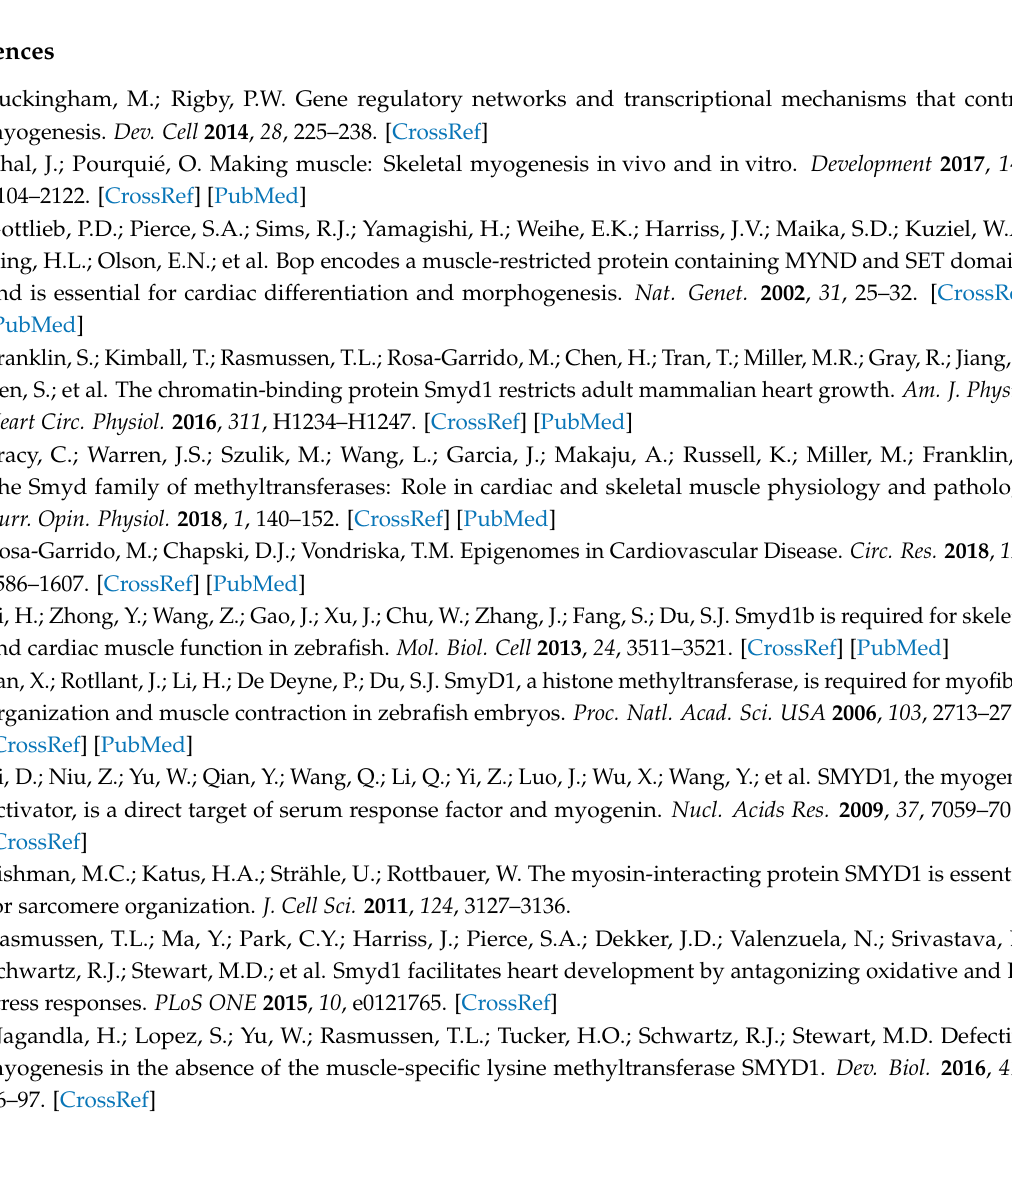
Figure S1: RT-PCR primer pairs and conditions. Figure S2: Primer sequences used for qPCR. Figure S3: Skeletal muscle Smyd1 deficiency does not affect transcript levels of Myogenic Regulatory Factors (MRFs). Figure S4: Transcript levels of TNF α and IL6 show gender variation in Smyd1 deficient skeletal muscle. Figure S5: Slow and fast muscle markers are altered. Figure S6: slow muscle fibers are